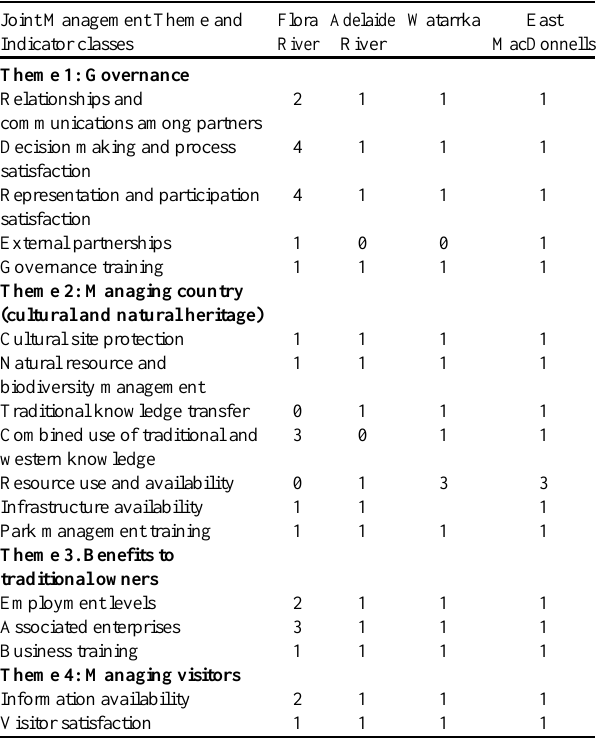
Table 2 . Spread of indicators across outcome classes (the number of crosses indicates the number of indicators in that class).